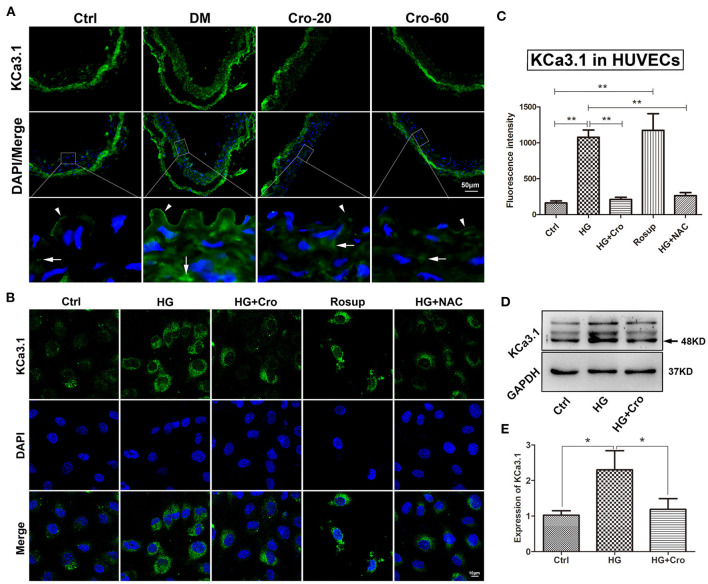
Crocin suppresses the upregulation of endothelial KCa3.1 induced by hyperglycemia. KCa3.1 expression profiles were explored in an aortic artery of diabetic mice and HG-cultured HUVECs to evaluate the regulatory role of crocin. (A) Immunofluorescence staining revealed KCa3.1 expression was significantly elevated in endothelial cells (arrow head) and vascular smooth muscle cells (arrow) in diabetes mellitus group (DM) compared to the control group (Ctrl), whereas its expression decreased in both crocin treatment groups. (B,C) Confocal images indicated that KCa3.1 was upregulated by HG in HUVECs, which was reduced by crocin (10 μmol/L) and NAC (10 μmol/L), respectively. Rosup (125 μg/ml), a positive control generating exogenous ROS, prominently enhanced the KCa3.1 expression in HUVECs. (D,E) Western blotting showed that crocin decreased the increased KCa3.1 induced by HG in HUVECs. DM, diabetes mellitus; Cro-20,−60, crocin 20, 60 mg/kg; Ctrl, control; Cro, crocin; HG, high glucose; NAC, N-acetyl-L-cysteine; HUVECs, human umbilical vein endothelial cells; ROS, reactive oxygen species. Results are shown as means ± SEM of three independent experiments. *p < 0.05, **p < 0.01. One-way ANOVA followed by Tukey's multiple comparisons test.